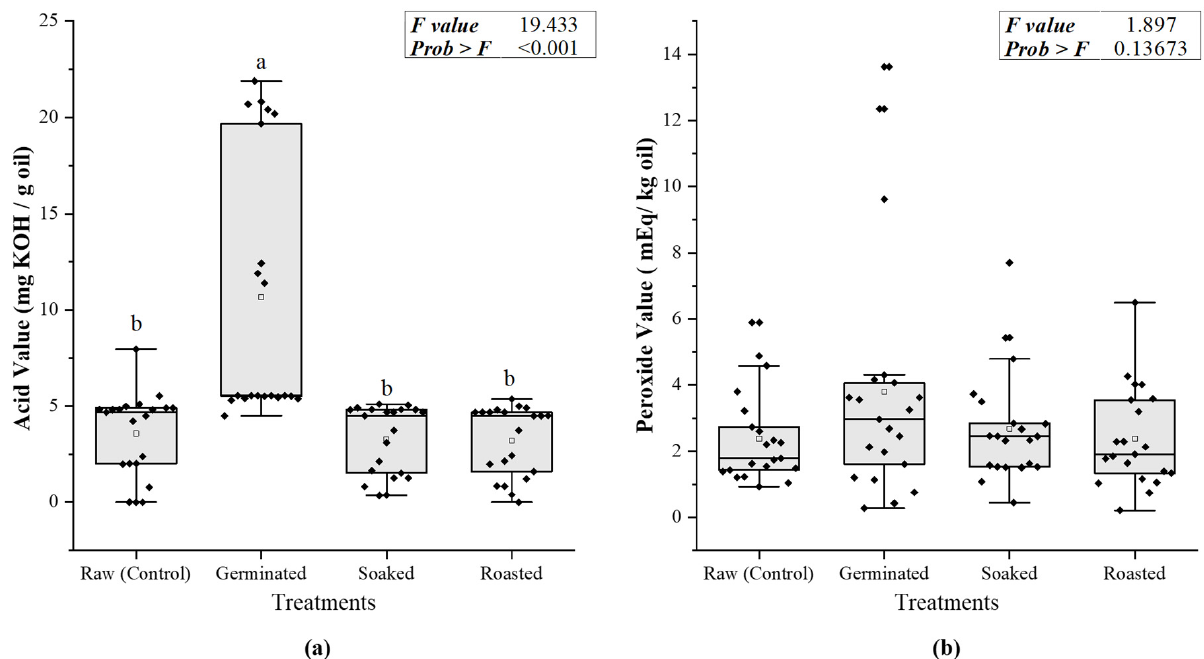
Figure 1. Average AV ( a ) and PV ( b ) of pretreated and raw FFSF at the end of 120 days of storage at both cities. Columns with different superscript letters ( a , b ) denote significant difference between treatments ( p < 0.05).